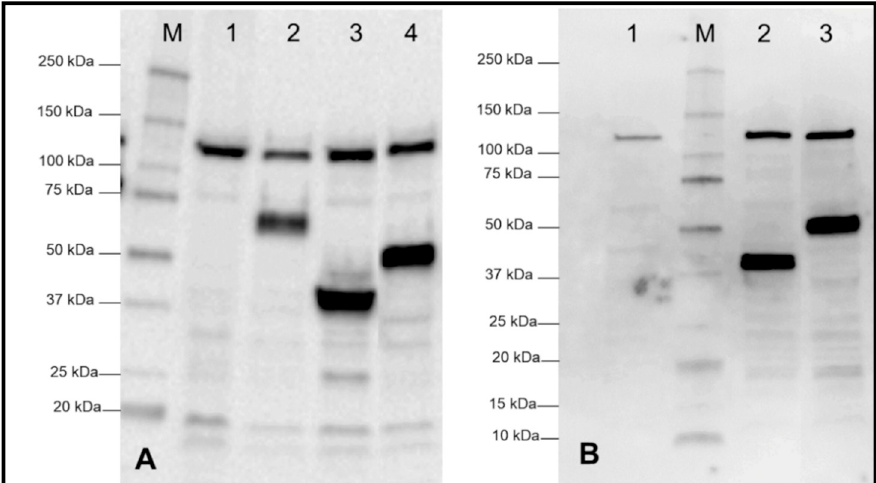
Figure 2. Western blot analysis of cell-free extracts from transformed and induced L. plantarum cells harbouring various expression plasmids. ( A ) erm -based expression system (1) pEV, empty vector as negative control; (2) pSIP_CsnAcwa2: inducible expression vector for cell wall anchoring of CsnA using cwa2 derived from the Lp_2578 protein as positive control [22]; (3) pLp0373_CsnA_S (expected protein size 39 kDa); (4) pLp0373_CsnA_L (expected protein size 52 kDa). ( B ) alr -based expression